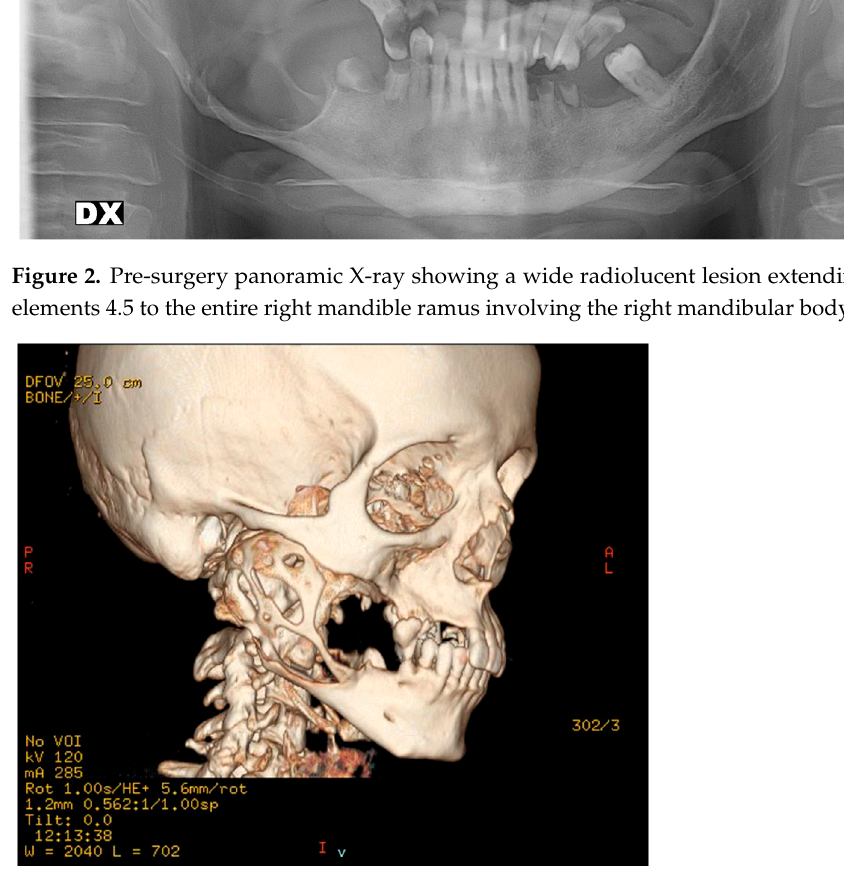
Figure 3. CT scan 3D reconstruction showing the huge lesion extending from dental elements and 5 to the entire right mandible ramus involving the right mandibular body and the alveolar nerve canal, with perforations of the cortical bone wall on both buccal and lingual sides.